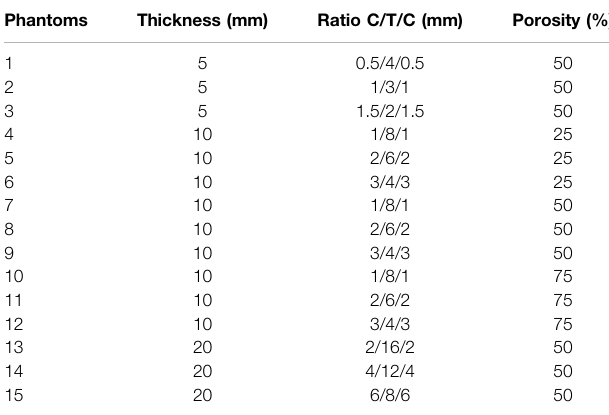
TABLE 1 | Conditions of sixteen 3D printed skull models (C: cortical bone, T: trabecular bone).